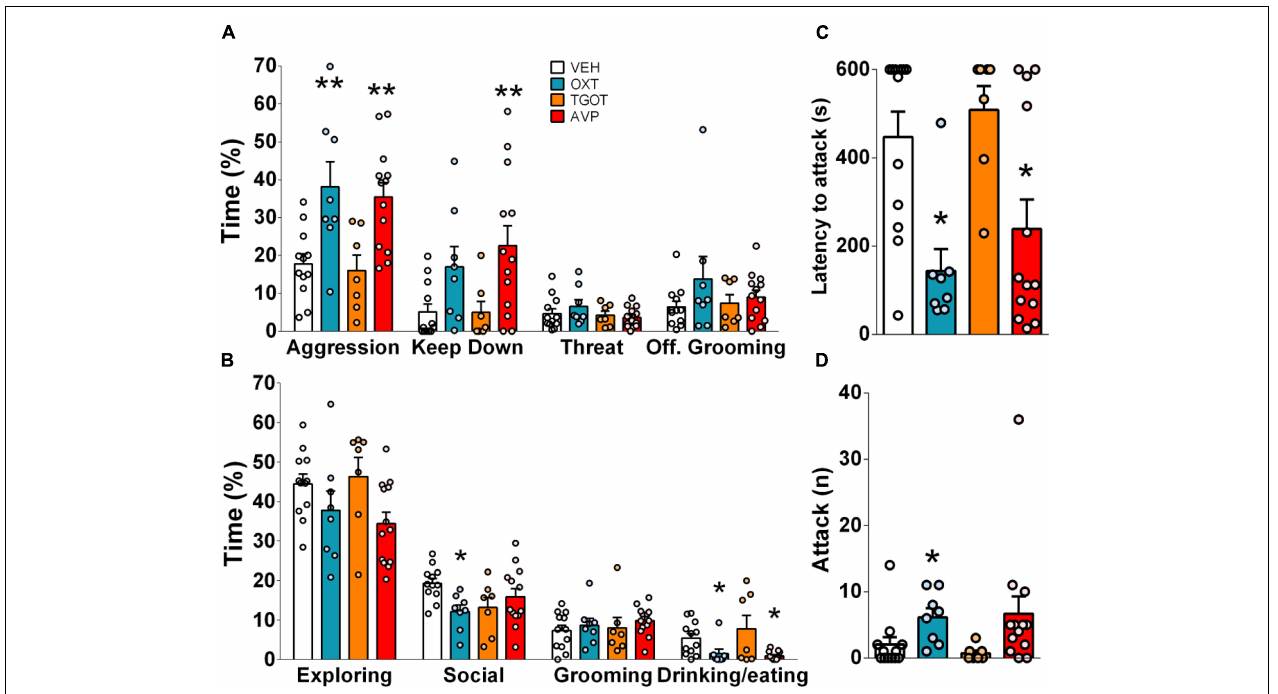
FIGURE 3 | Infusion of synthetic vasopressin (AVP, red bars, 0.1 ng/0.5 µ l per side) and oxytocin (OXT, blue bars, 10 ng/0.5 µ l per side) but not TGOT (selective OXTR agonist, orange bars, 10 ng/0.5 µ l, per side), into the central amygdala increased percentage of time spent on total aggression in IST rats (A) . Particularly, AVP increased the percentage of time spent on total aggression and keep down (A) , and reduced the latency to attack (C) . Whereas OXT heightened the percentage of time spent on total aggression (A) , the number of attacks (D) , and decreased the latency to attack (C) and the percentage of time spent on the non-aggressive social investigation (B) . Both peptides reduced the percentage of time spent feeding and drinking. Data presented as mean + s.e.m. * p < 0.05 vs. VEH; ** p < 0.01 vs.